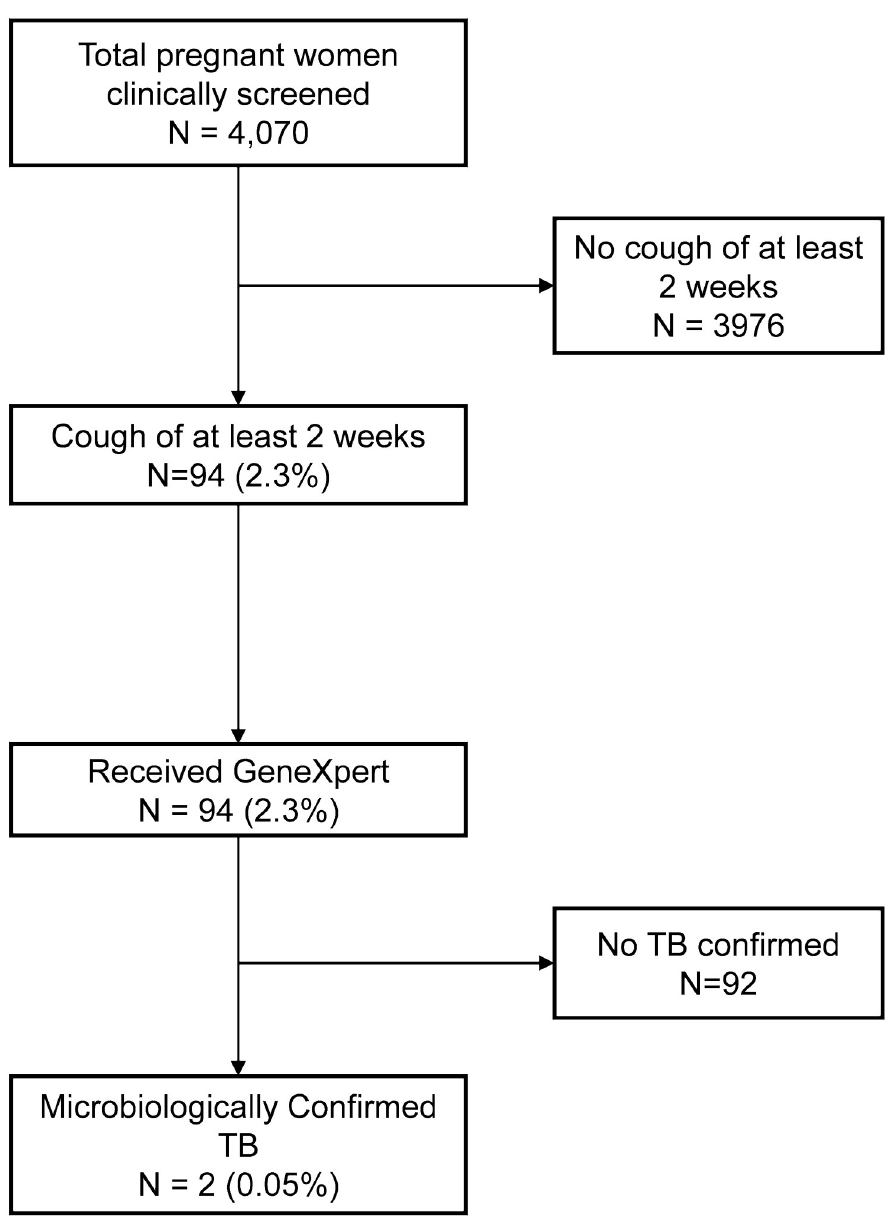
Fig 1. Flow diagram of participants through the